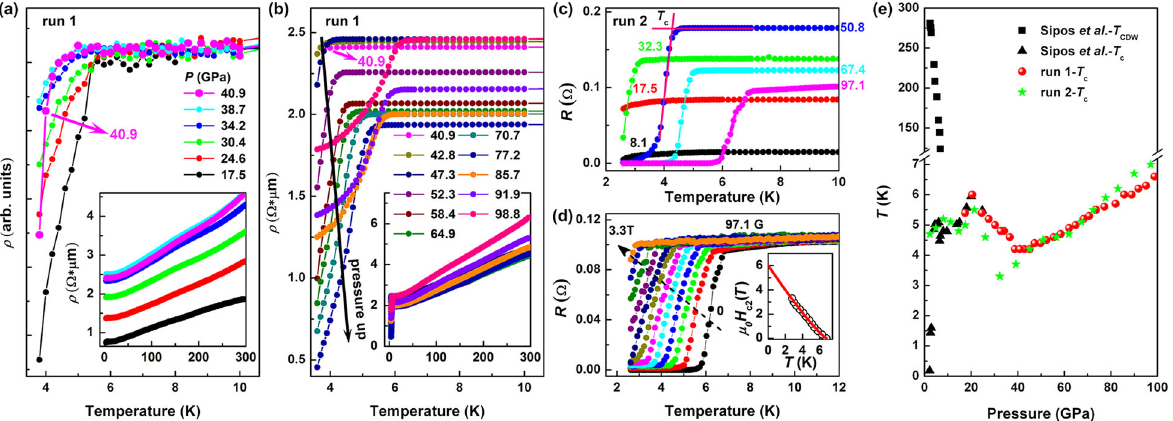
Fig. 1 Pressure-induced superconductivity in 1T-TaS 2 . Temperature-dependent resistivity under pressures ranging from a 17.5 to 40.9 GPa (normalized to the same magnitude at elevated pressures) and b 40.9 to 98.8 GPa in run 1. c Temperature-dependent resistance curves under high pressure in run 2. Zero resistance has been measured since 50.8 GPa. d shows the R – T curve under increasing magnetic fi eld at 97.1 GPa. The criterion for determining T c in two runs is shown in c . Inset of d plots the best fi t of T c vs H using the empirical formula H c2 ( T ) = H c2* (1 – T / T c ) 1 + α . e Temperature – pressure phase diagram of TaS 2 ; the black solid squares and triangles represent the T CDW and T c from previous electrical resistivity measurements 20 . The red solid circles and green stars represent the T c measured in this